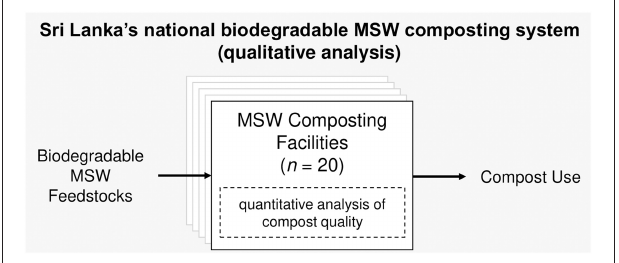
FIGURE 2 | Our case study framework with multiple embedded units and concurrent embedded design for data